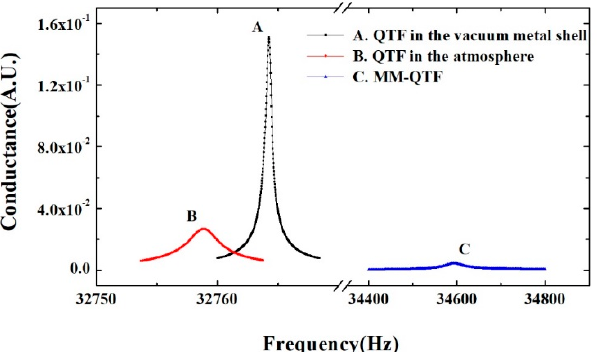
Figure 3. Conductance spectroscopy of QTF in the vacuum sealed metal shell (squares), QTF in the air (diamond), and QTF modified by polymethyl methacrylate (PMMA) microwire (triangle), respectively. Table 1. The QTF parameters obtained by conductance spectroscopy.